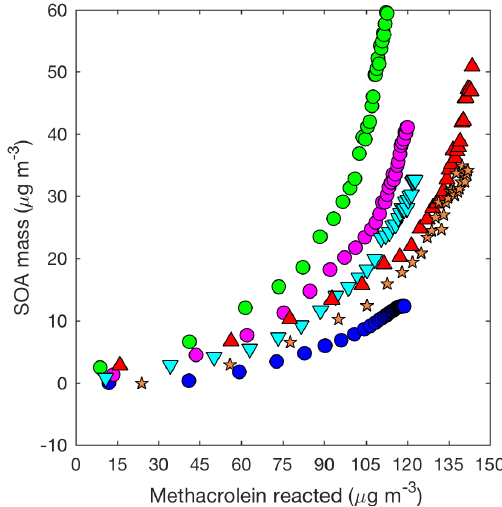
Figure 6. SOA mass yield (20min averages) as measured by the DMA assuming a density of 1.4µgcm − 3 for 2MGA path- way experiments: seed surface area (SA) – M1 (SA = 0µm 2 cm − 3 ; blue dot), M2 (SA = 1640µm 2 cm − 3 ; magenta dot), and M3 (SA = 2260µm 2 cm − 3 ; green dot), temperature – M5 (13 ◦ C; in- verted cyan triangle) and M6 (32 ◦ C; red triangle), and new cham- ber with less wall charging – M9 (SA = 1910µm 2 cm − 3 ; orange